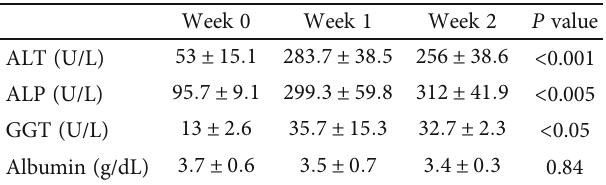
Table 1: Comparisons of ALT, ALP, GGT, and albumin